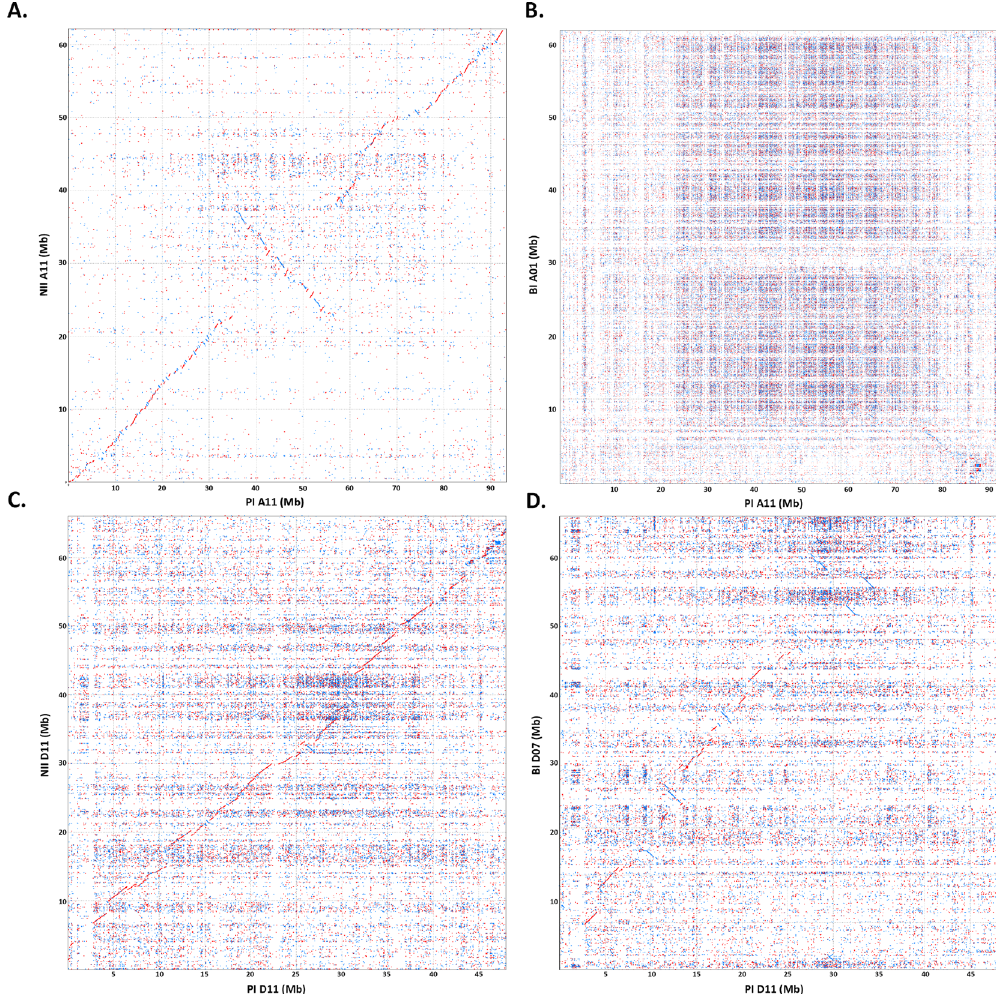
Figure 4. ( A ) Dot plot of the pilot BAC pseudochromosome (PI A11) as aligned to the corresponding NI A11 draft pseudomolecule. ( B ) Dot plot of the pilot BAC pseudochromosome (PI A11) as aligned to the corresponding BI A01 draft pseudomolecule. ( C ) Dot plot of the pilot BAC pseudochromosome (PI D11) as aligned to the corresponding NI D11 draft pseudomolecule. ( D ) Dot plot of the pilot BAC pseudochromosome (PI D11) as aligned to the corresponding BI D07 draft